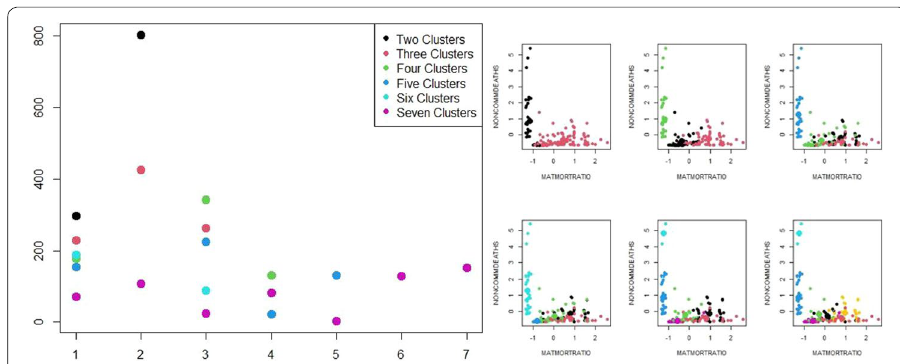
Fig. 5 The within cluster variations (LHS) and each of the six cluster categories (RHS)